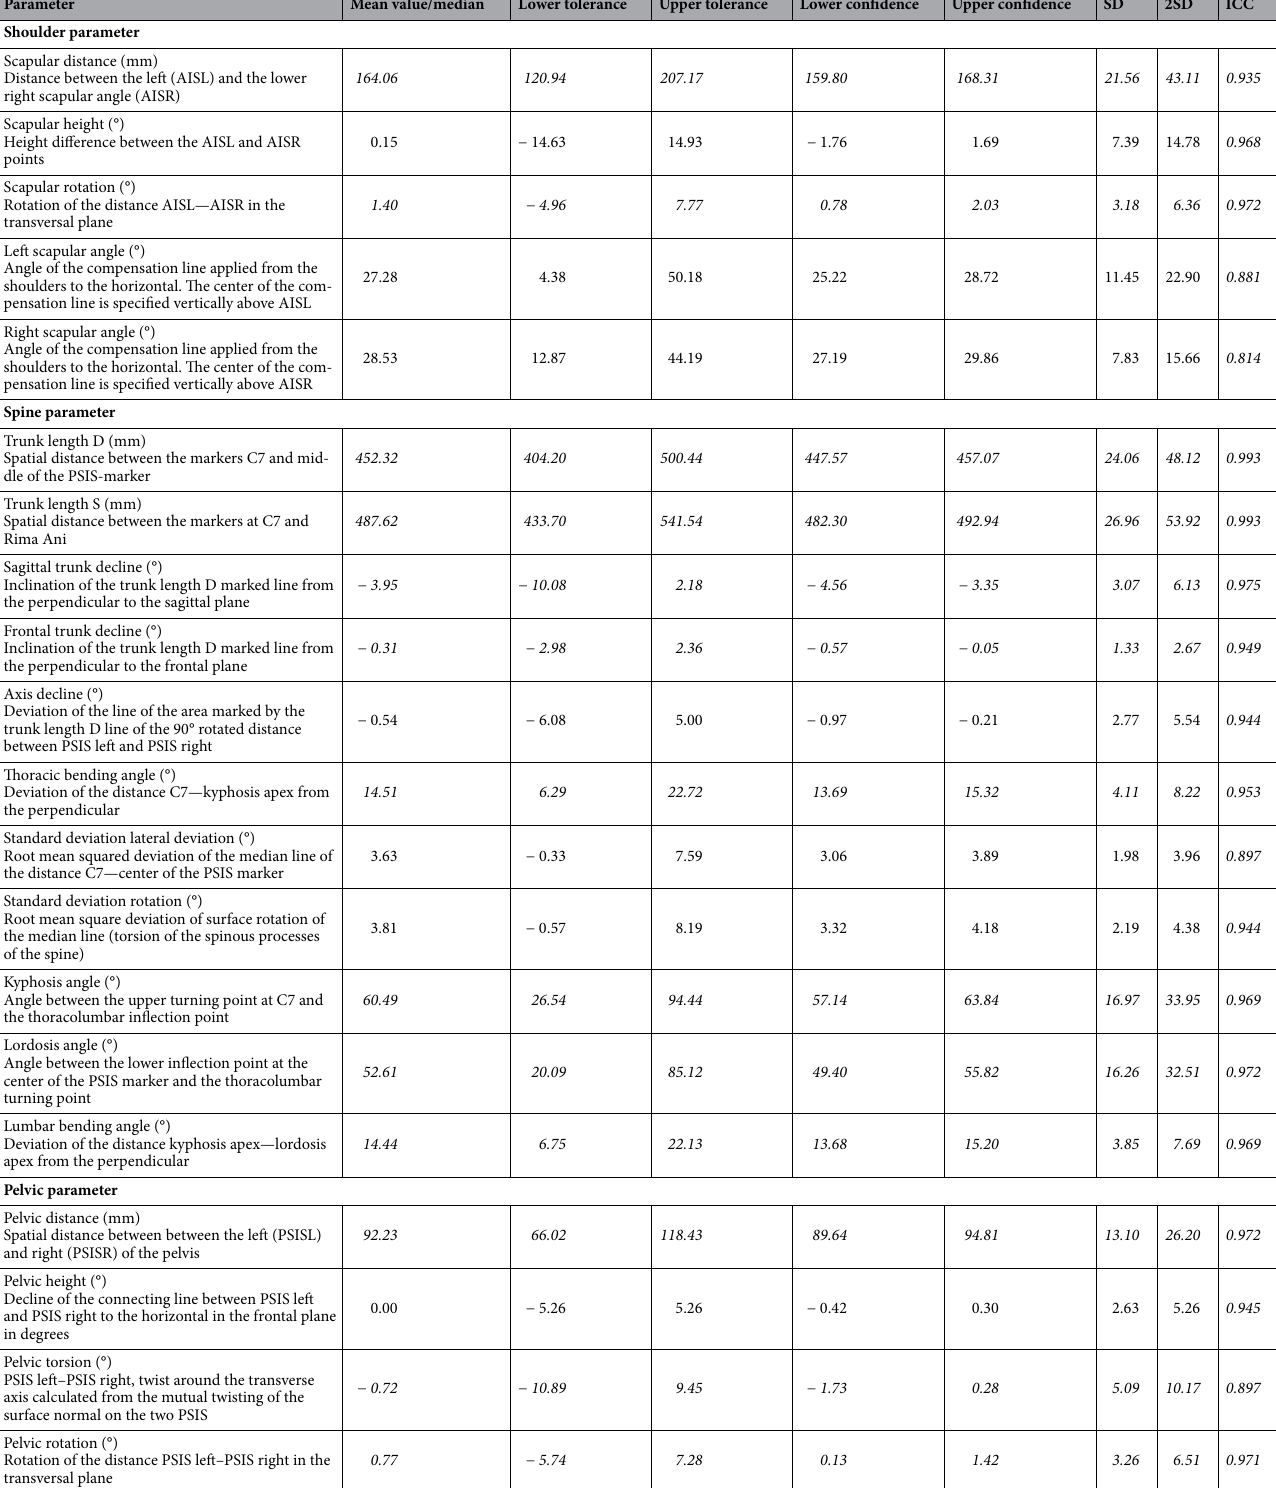
Table 1. Upper body posture parameters including the mean or median values, tolerance range, confidence interval, standard deviation and 2 standard deviation. A description of the parameters can be found directly below each respective parameter. Normal distributed data are in italics. ICCs were classified as follows: 0–0.20 = “slight”, 0.21–0.40 = “fair”, 0.41–0.60 = “moderate”, 0.61–0.80 = “substantial”, 0.81–1.00 = “(almost) perfect”. Data not normally distributed are printed in